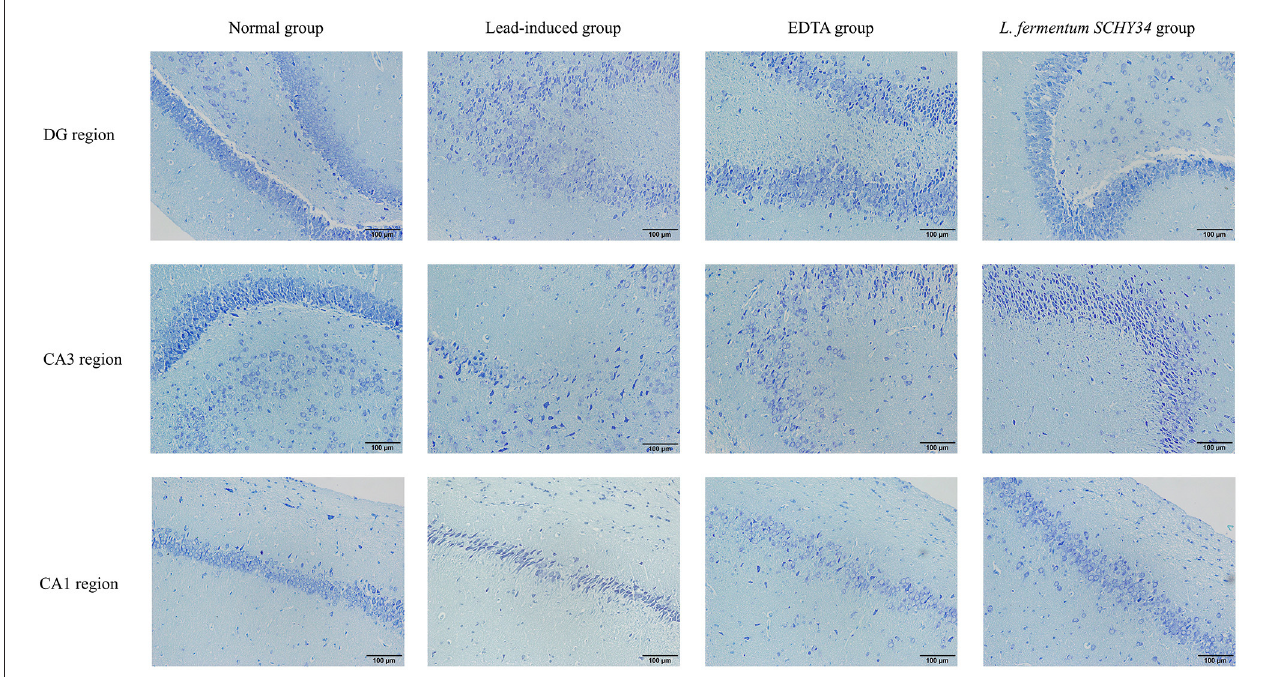
FIGURE 4 | Pathological observation of hippocampus DG region, CA3 region and CA1 region in SD rats: (Nissl-stained section).